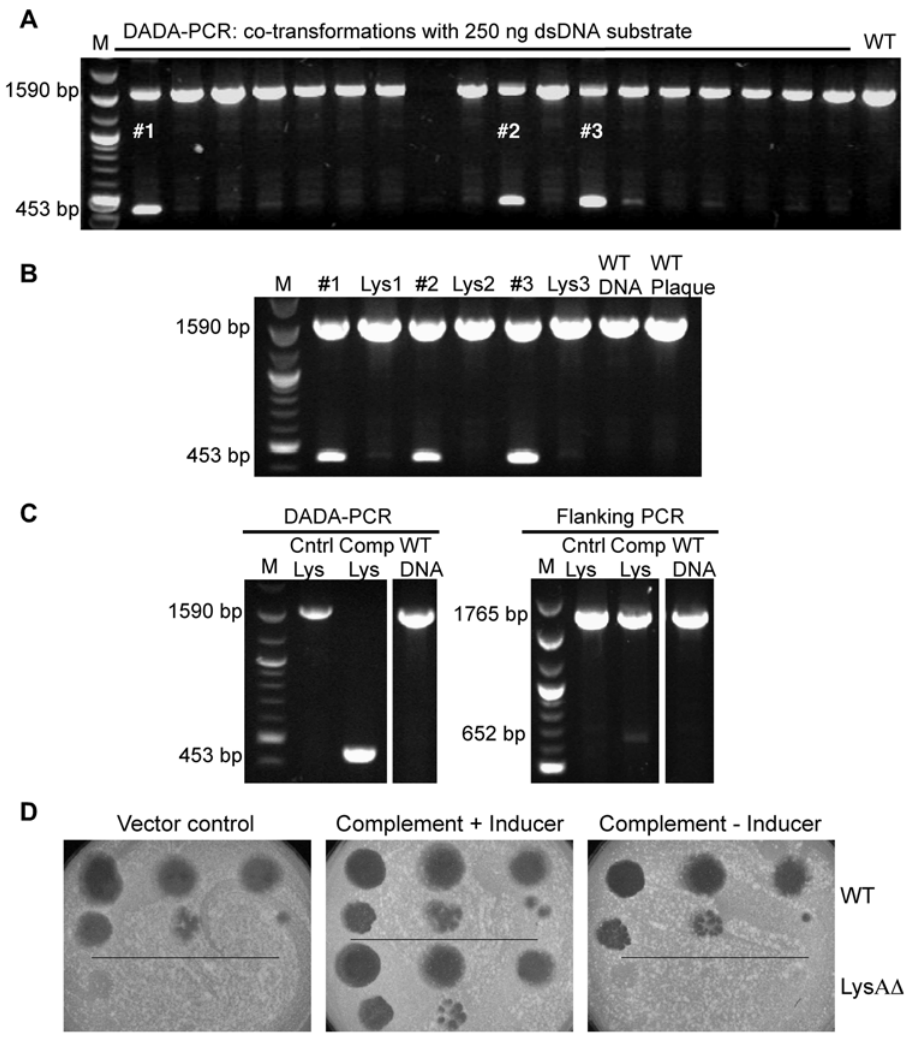
Figure 3. Use of BRED to construct a deletion mutant of the essential Giles lysA gene. a. A 200 bp dsDNA substrate designed to introduce a 1173 bp deletion in Giles lysA was co-electroporated with Giles DNA into recombineering cells, and individual plaques were tested using DADA- PCR. Three mixed plaques are indicated ( # 1, # 2, # 3). b. The three mixed-plaques marked in part a were re-plated, and lysates were generated from plates containing 1000–5000 plaques. Each lysate (Lys) and the original mixed plaque were analyzed by DADA-PCR with loss of the mutant in the lysate suggesting that lysA is an essential gene. c. Mixed plaque # 3 was re-plated on either M. smegmatis (Cntrl) or a recombinant strain expressing the Corndog lysA gene (Comp), and lysates were harvested from plates containing , 2000 plaques. Screening by DADA-PCR or flanking PCR shows that the mutant is propagated in the complementing but not in the wild-type strain. d. The LysA D mutant was purified from the complementation strain and confirmed by PCR and DNA sequencing. Serial dilutions of mutant (lower parts) and wild-type phage (upper parts) were spotted onto lawns seeded with either the vector control cells or the complementation strain in the presence or absence of acetamide, as indicated.